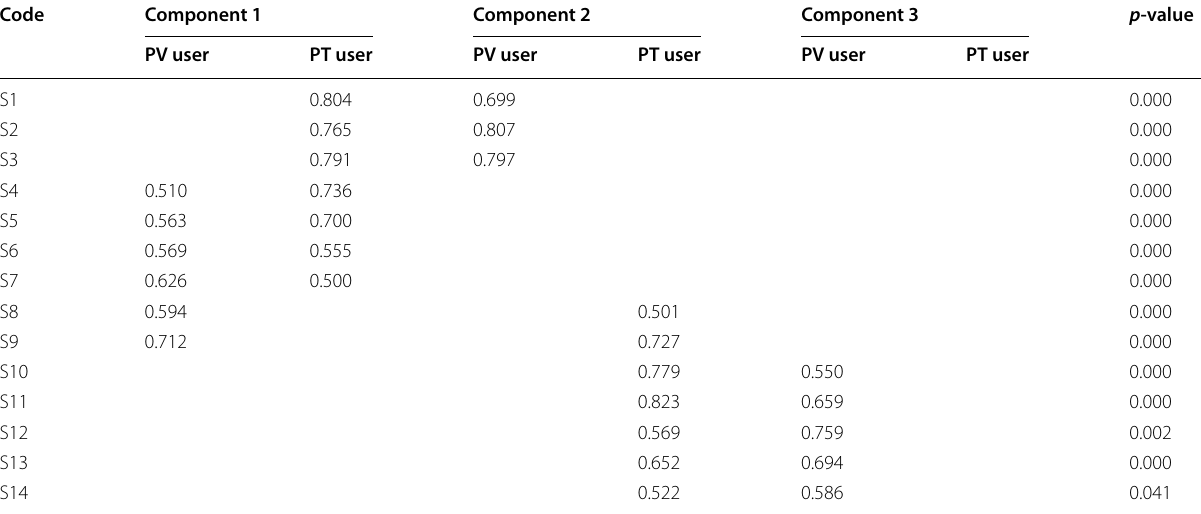
Table 3 The PCA for measuring the perceived service quality and travelers’ satisfaction